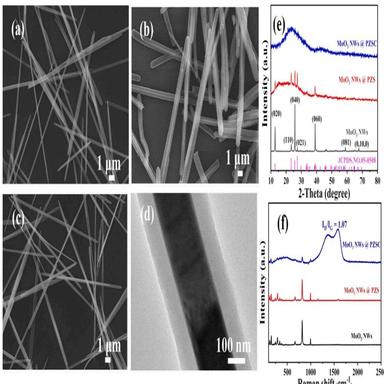
SEM of (a) MoO3, (b) MoO3 @ PZS and (c) MoO3 @ PZSC. (d) TEM of MoO3 @ PZS. (e) XRD of MoO3 @ PZSC, MoO3 @ PZS and MoO3. (f) Raman spectra of MoO3 @ PZSC, MoO3 @ PZS and MoO3.